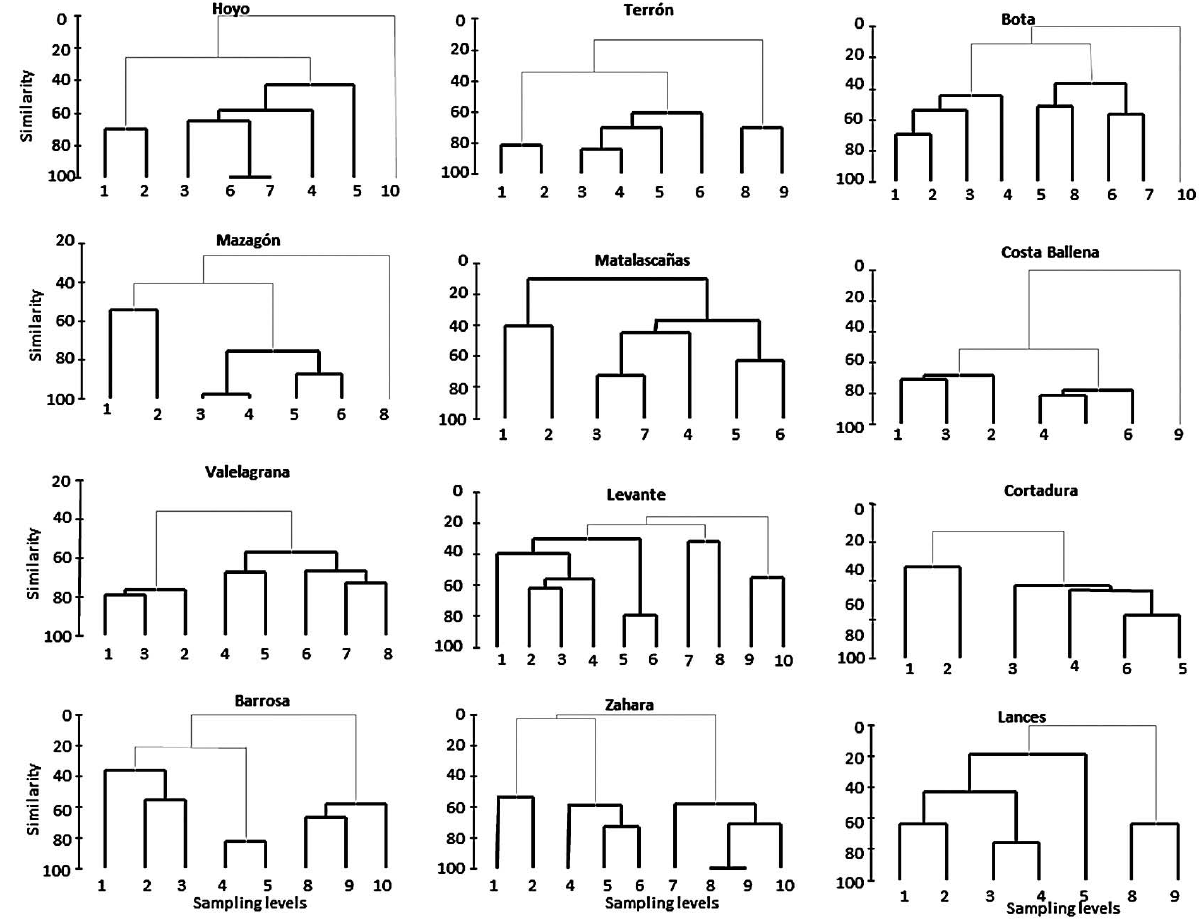
Fig. 2. – Zonation pattern in each studied beach defined by similarity profile (SIMPROF). Grey lines represent significant evidence of com- munity structure (P<0.05). Black lines indicate no significant